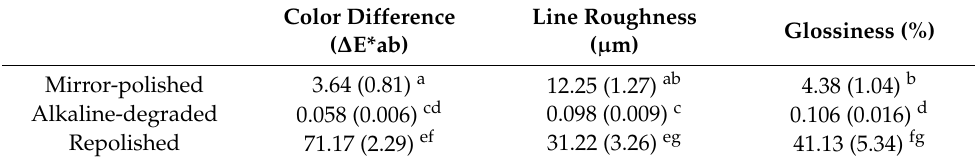
Figure 7. Color difference after the discoloration test. The bars (*) indicate the statistical difference (Bonferroni’s test, p < 0.001, n = 15). Table 3. Result of